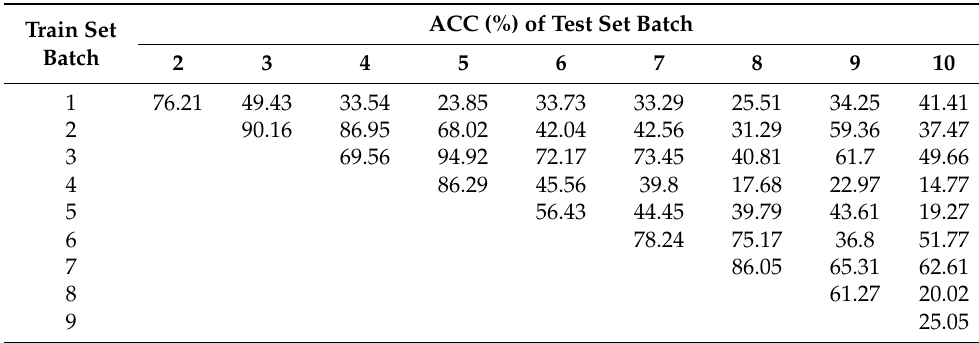
Table 3. The classification accuracy of only SVM (use batch m as the training set and batch n as